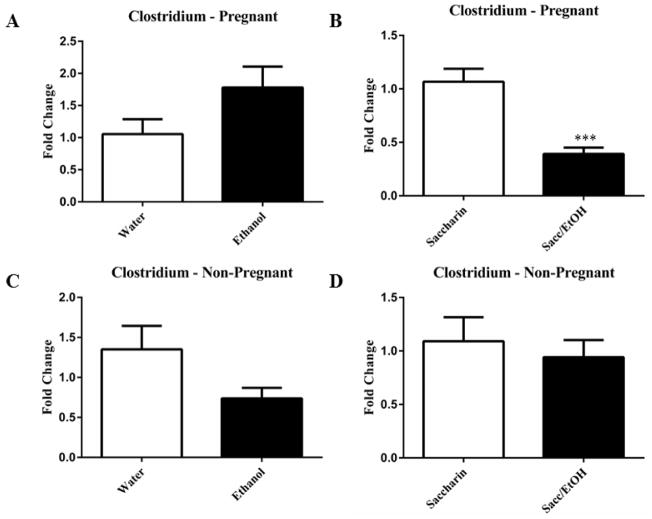
Drinking ethanol and saccharin together reduced levels of Clostridium in pregnant miceEthanol in water solutions increased Clostridium levels in pregnant animals (1A) and decreased in non-pregnant animals (1C) but this did not reach significance. Ethanol and saccharin in water (1B) significantly decreased Clostridium levels in pregnant animals. No change was found in non-pregnant ethanol and saccharin in water drinking animals (1D). Data are expressed as mean fold change ± SEM, n=9–10 mice. Ethanol conditions are presented in the filled columns and controls (water or saccharin alone) are in the unfilled columns. *** t (17) =4.85, p=0.0001, n=9–10 (1A).